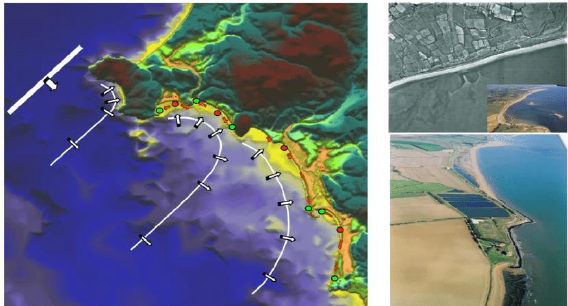
Figure 2 . Examples of crenulate bay (Brew, et. al.